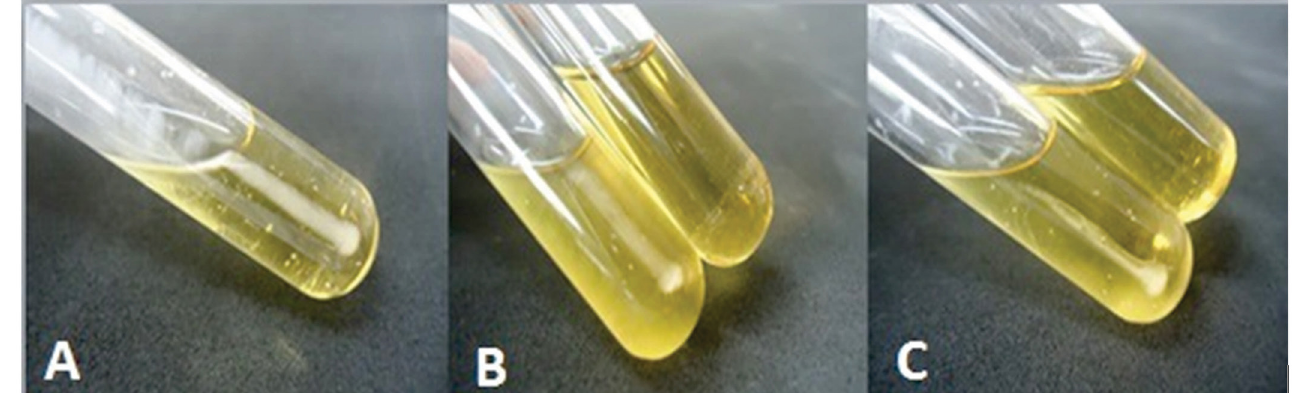
FIGURE 1 - MICA test against S. mutans ATCC 25175, positive control (A); fraction in Butanol of Rosmarinus officinalis in concentrations of 12.5 mg/mL and 6.25 mg/mL (B); and chlorhexidine in concentrations of 25 µg/mL and 12.5 µg/mL (C), TABLE V - MICA results against S. mutans ATCC 25175 strain for ethanol extract and Rosmarinus officinalis fractions and